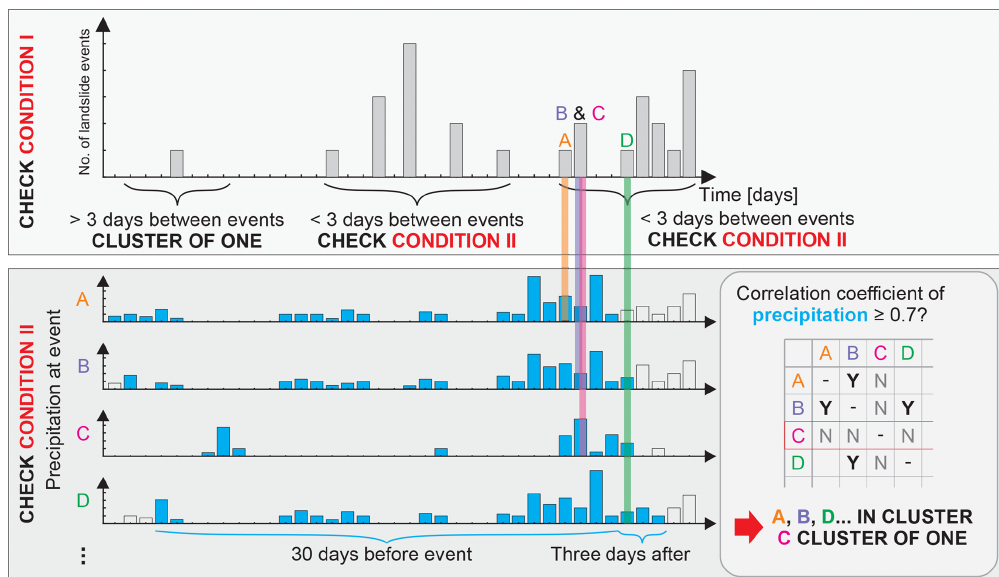
Figure 2. Schematic drawing of the algorithm used to identify if two landslide events within the Global Landslide Catalog (GLC) occurred during the same rainfall event, and hence belong to the same cluster. For Condition II, only events occurring within 3d of each other are compared.